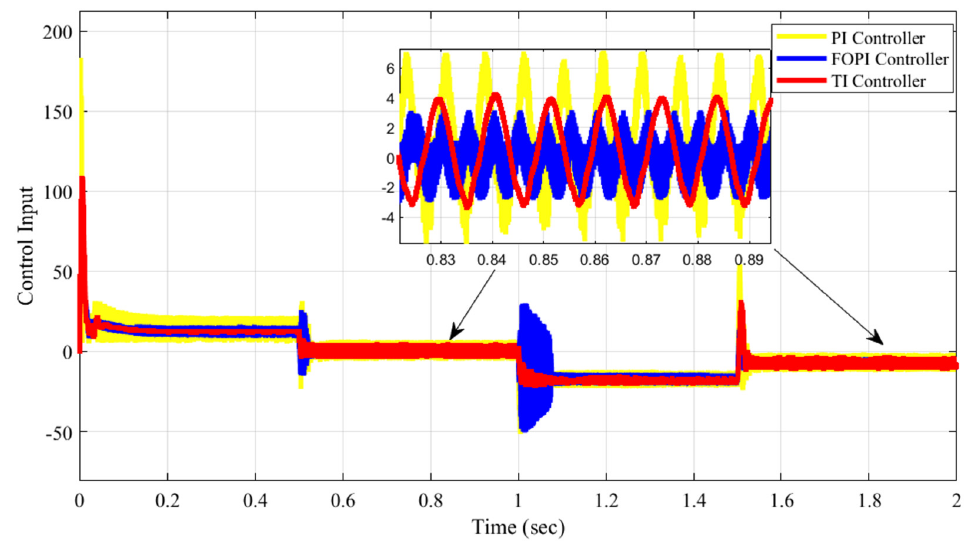
Figure 7. Optimization performance plot of the proposed TI controller using Nelder–Mead and PSO.